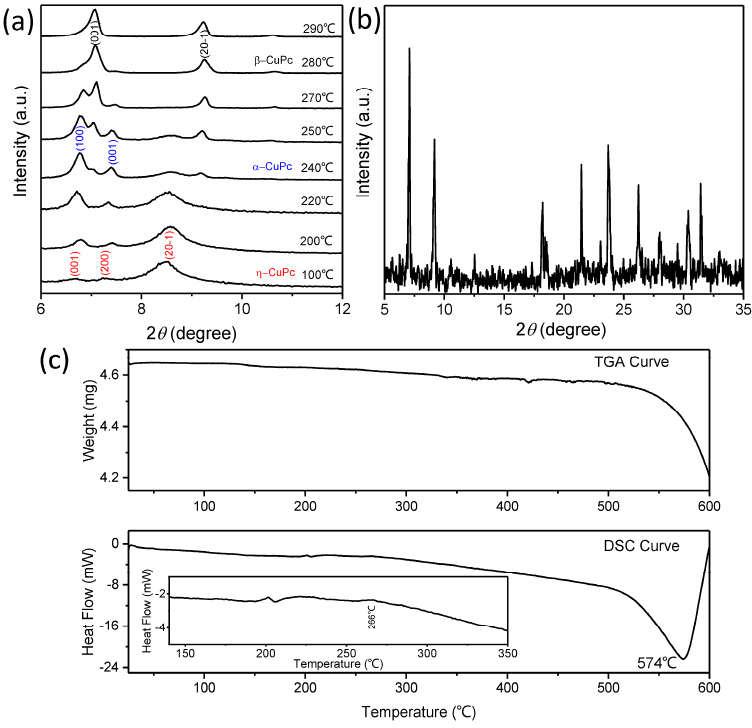
Figure 4. ( a ) XRD patterns of CuPc crystals annealed at different temperature; ( b ) the XRD pattern